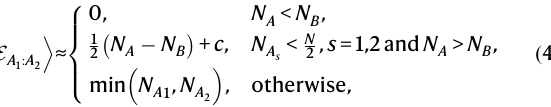
i . The error bars represent stan- the negativity approximately obeys volume law. In contrast, the negativity is 1 : A 2 saturated from N A =2 and N A =4, then =2 to 4 when N B 1 2 1 from0to6.When N B =0, 1